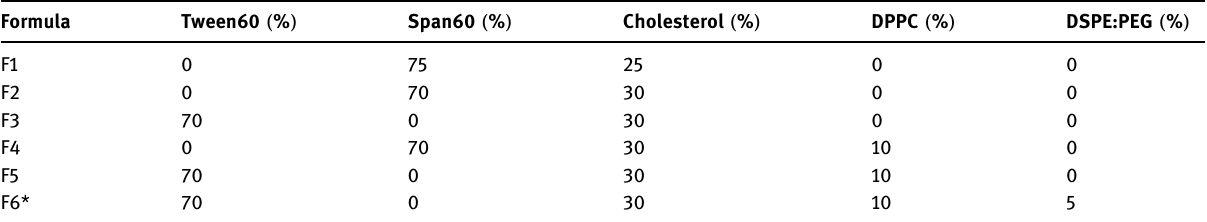
Table 1: Type of surfactant, di ff erent molar ratios of non - ionic surfactant l/cholesterol, and type of lipids used in synthesizing di ff erent Nio - GGE